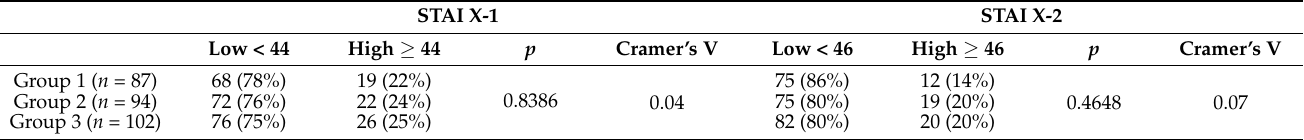
Table 3. Prevalence of anxiety in the three groups (the χ 2 test).